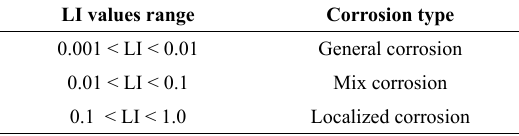
Table 5. Correlation between localized index (LI) and corrosion type.